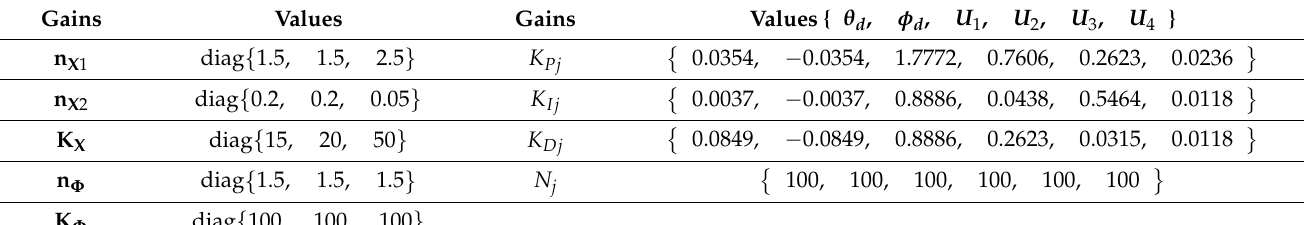
Table 2. Controller gains used in the